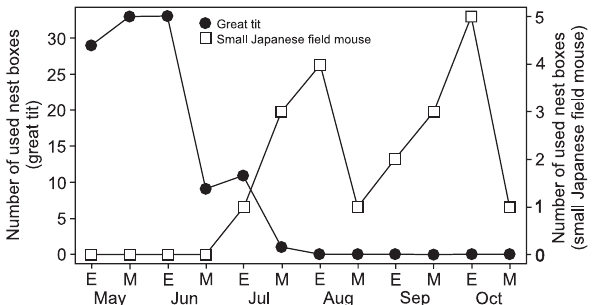
Figure 1. Number of nest boxes used by Parus major and Apode- mus argenteus in 2012. On the x-axis, E indicates “Early” and M indicates